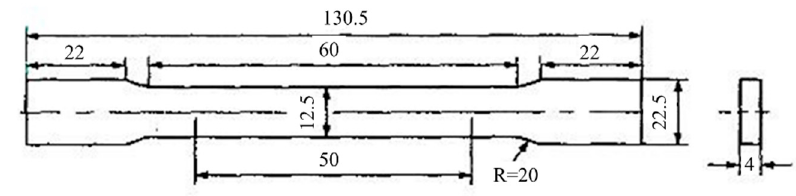
Figure 1. Drawing of the tensile test sample; the unit is mm.